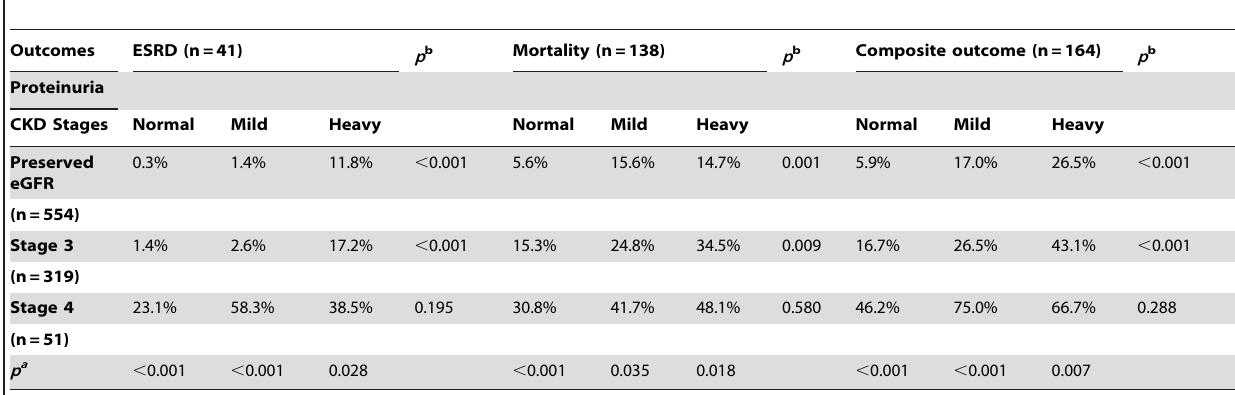
Table 3. Adverse outcomes in 925 CABG patients with various CKD stages and degrees of